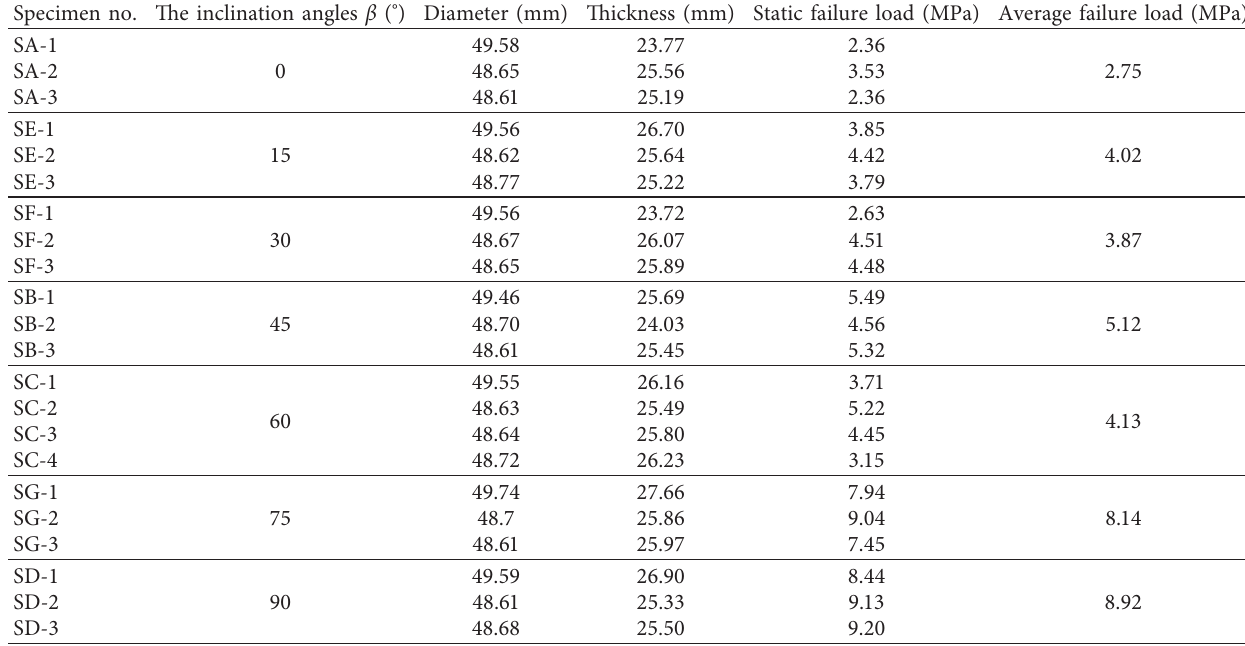
Table 2: Summary of the static tensile test results on samples.